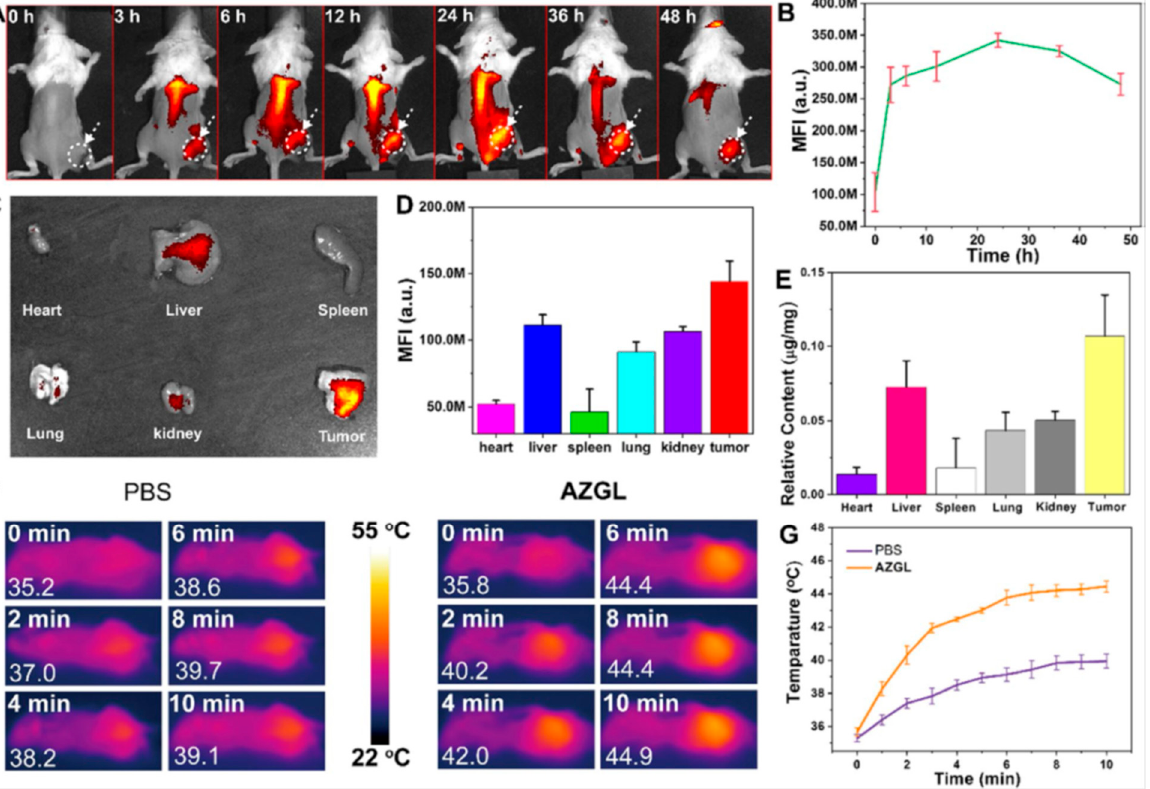
Figure 3. ( A ) In Vivo FL images ( B ) mean fluorescence curve after i.v. of AZGL ( C ) Ex-vivo fluores- cence imaging of organs ( D ) mean fluorescence intensity of tumor and organs after i.v. of AZGL ( E ) The relative content of Au treated mice after i.v. of AZGL. ( F ) In Vivo IR thermal imaging and ( G ) the temperature change curves after i.v. of PBS and AZGL with 980 nm laser treatment for 10 min. Reproduced with permission [184]. Copyright 2022 Springer Nature.